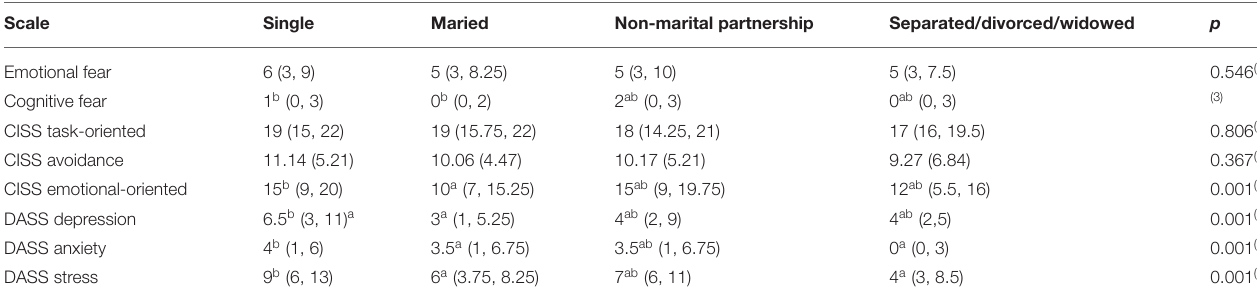
TABLE 3 | Median (1st quartile, 3rd quartile), or mean and standard deviation, for each scale by marital status of the researchers and p -value from analysis of variance [ ( 1 ) parametric ANOVA, ( 2 ) Kruskal–Wallis test, ( 3 ) Games–Howell test]. Scale Single Maried Non-marital partnership Separated/divorced/widowed p